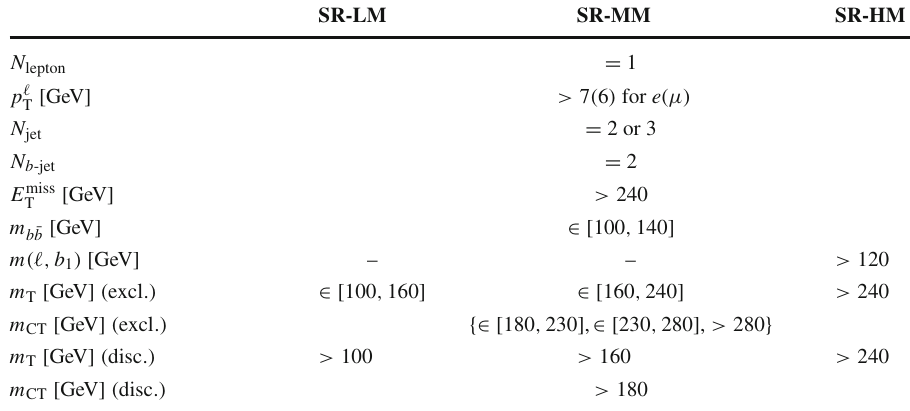
Table 2 Overview of the selection criteria for the signal regions. Each of the three ‘excl.’ SRs is binned in three m CT regions for a total of nine ‘excl.’ bins